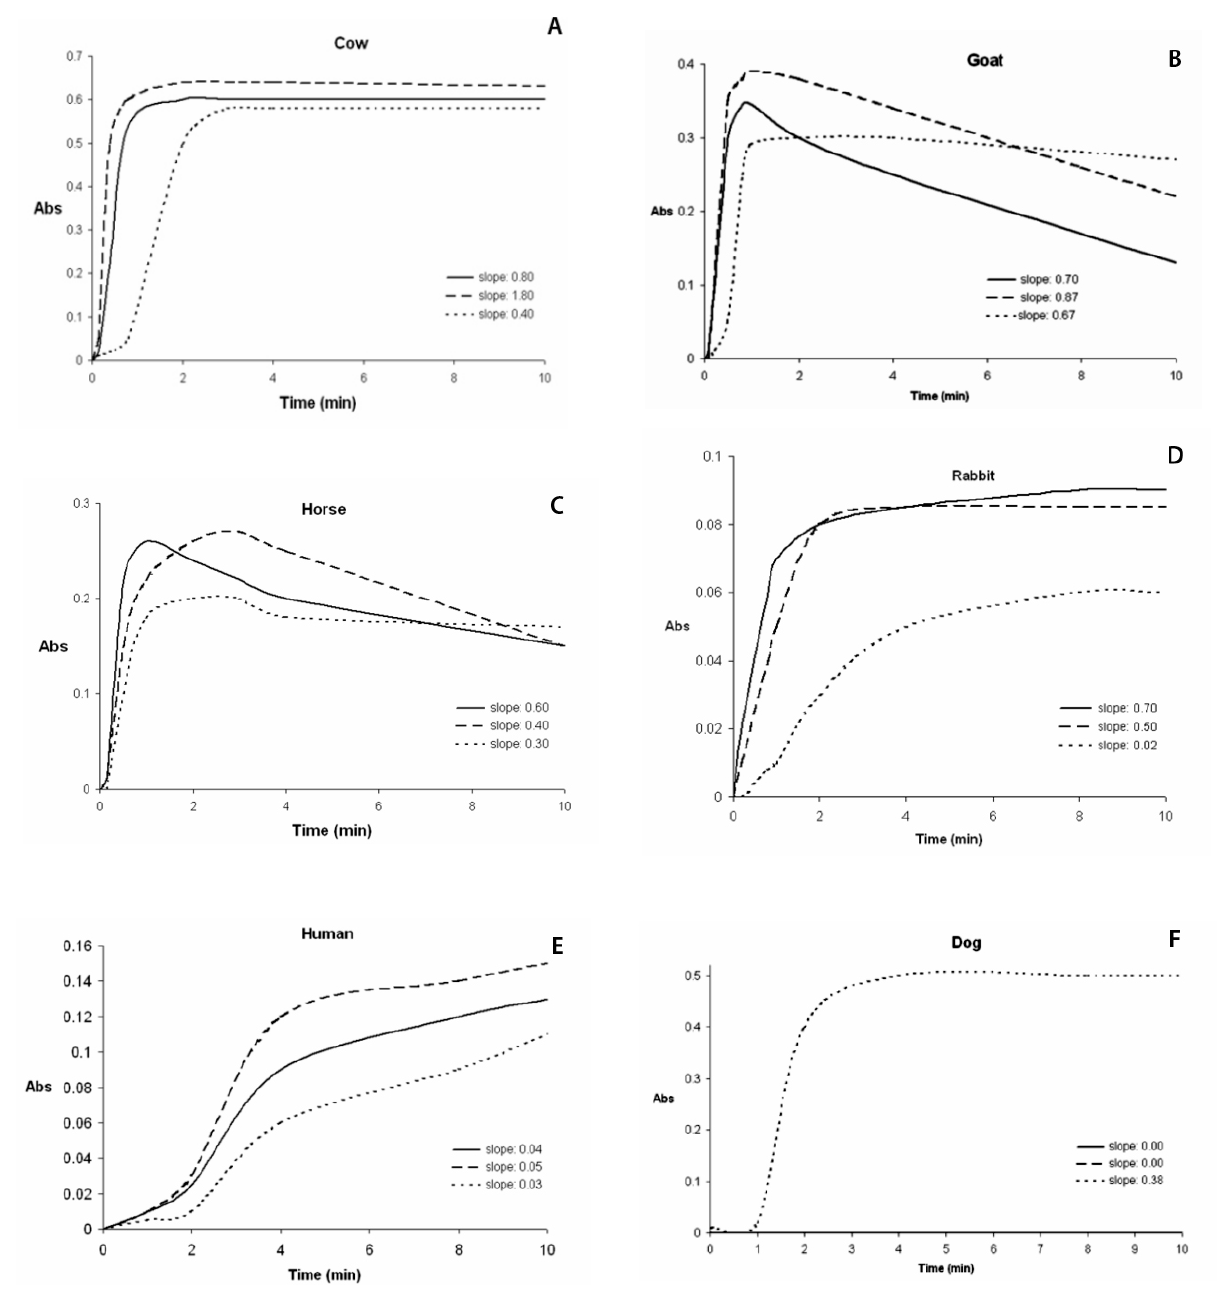
Figure 2. Time course of thrombin-like enzyme activity of three different crotalid venoms on fibrinogens from several mammals ( A : cow; B : goat; C : horse; D : rabbit; E : human; F : dog). The slope (gradient) for each curve is calculated from the steepest upward portion of the graph representing the maximal clotting rate expressed as absorbance/minute. Absorbance reflects the change in mixture clarity, which is responsible for the formation of fibrin strands as well as their dissolution/degradation. “Clot” used in this discussion represents the formation of fibrins. The crotalid species are: ─ H. hypnale ; --- C. rhodostoma; ∙∙∙∙ C. purpureomaculatus